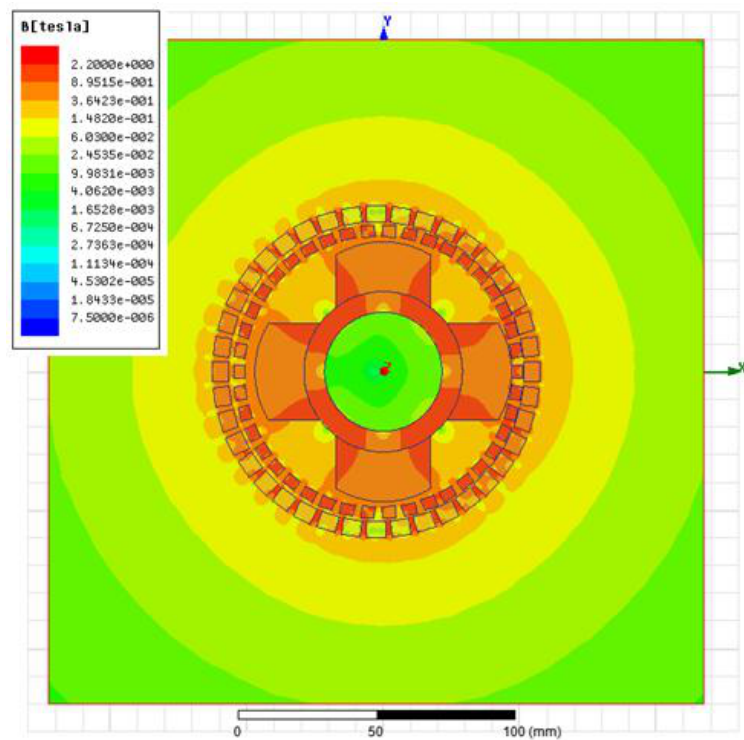
Figure 2. Magnetic simulation of MAGDRIVE